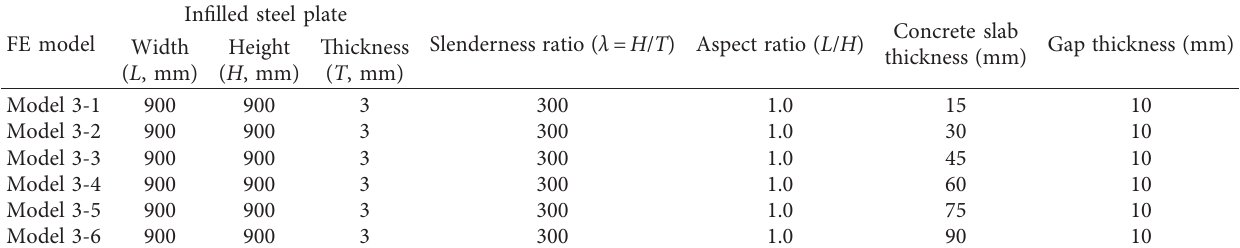
Table 11: Details of FE models (concrete slab thickness).